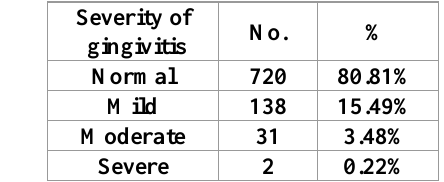
Table 5: Distribution of the children according to the severity of gingivitis .